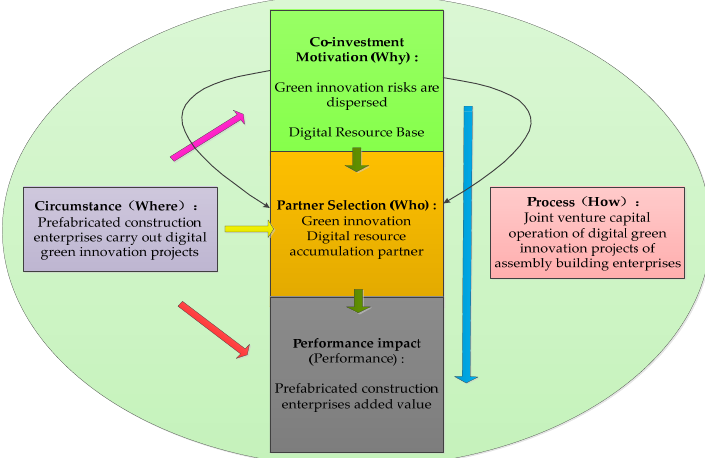
Figure 2. PCEs choose the joint investment partner 3W1H-P research framework.